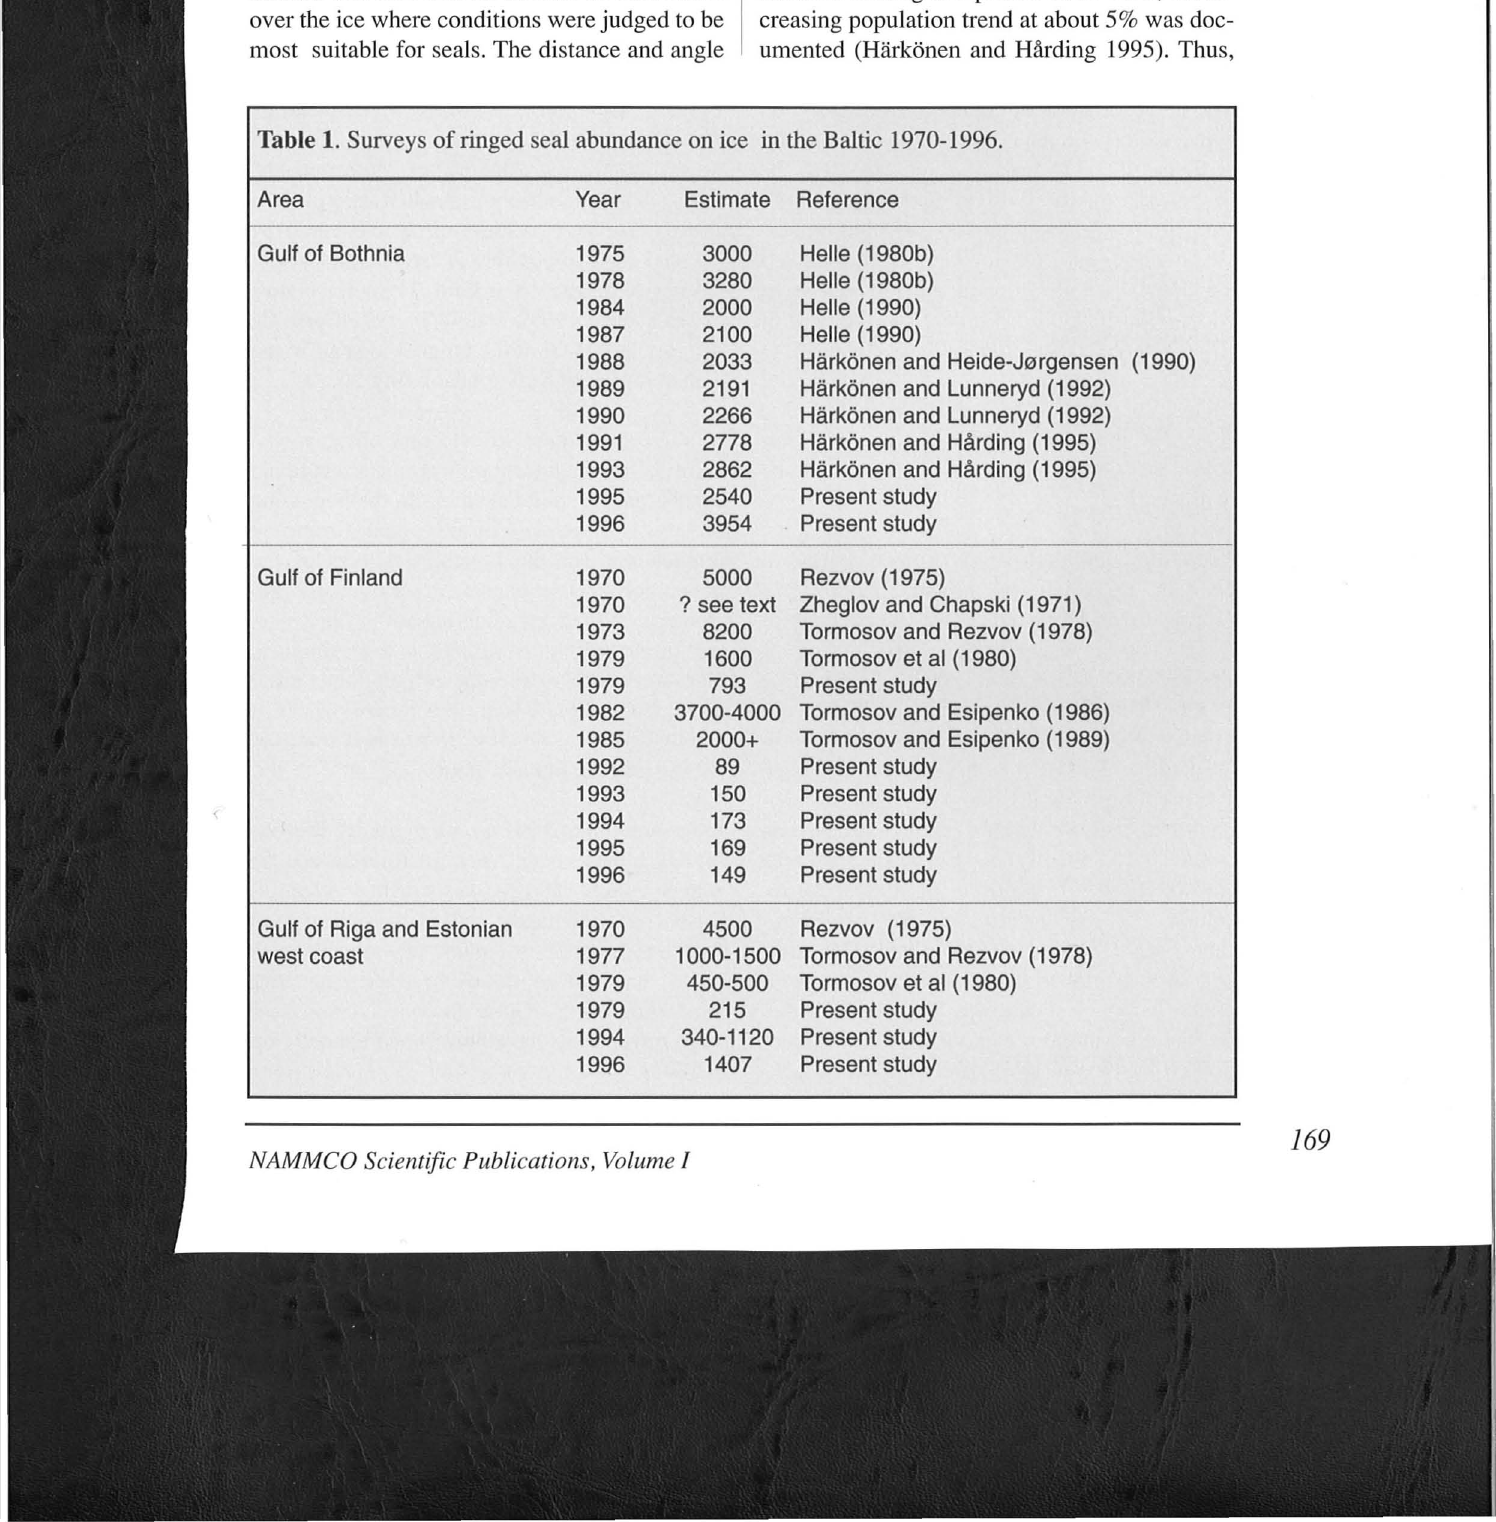
Table 1. Surveys of ringed seal abundance on ice in the Baltic